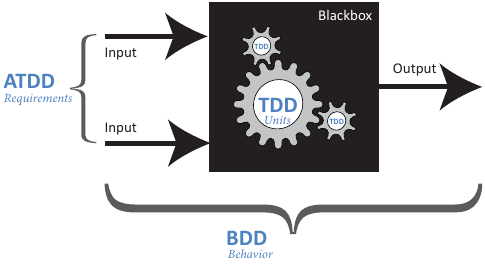
Figure 6. TDD, BDD, and ATDD and where they do apply to a software